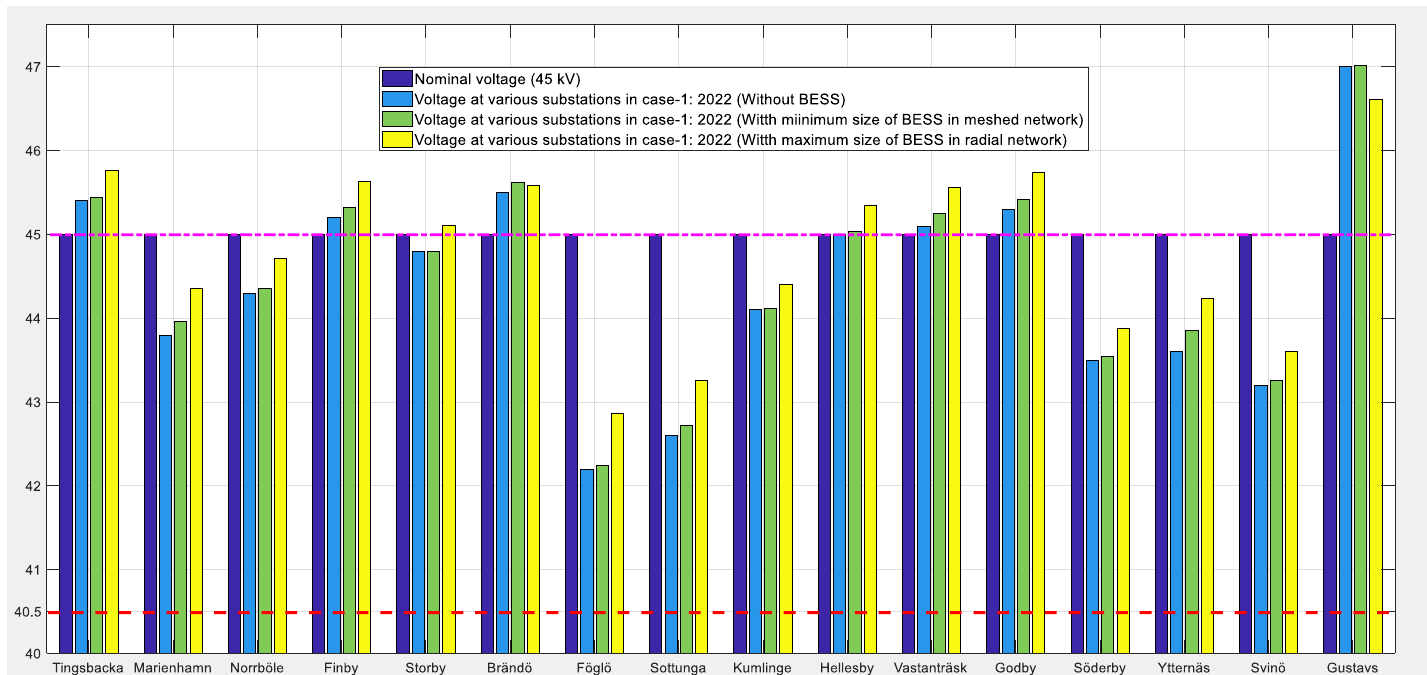
Figure 13. Nominal and operating voltages at the substations for the year 2022 with BESSs.